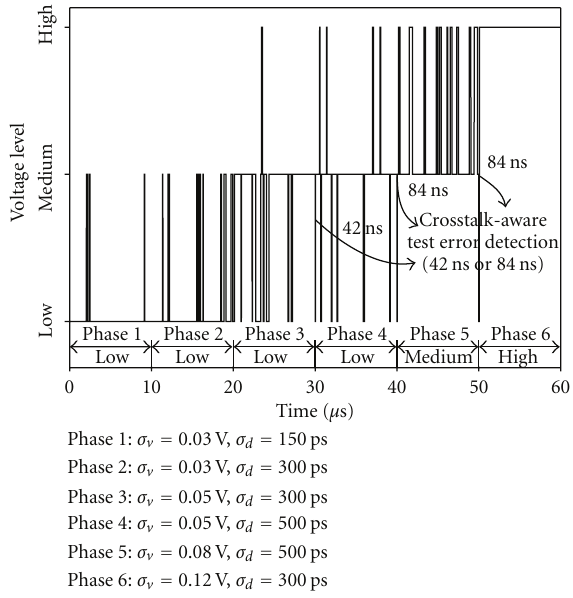
Figure 20: Voltage levels of the self-calibrated voltage scaling tech- nique under six phases with di ff erent noise distributions and timing